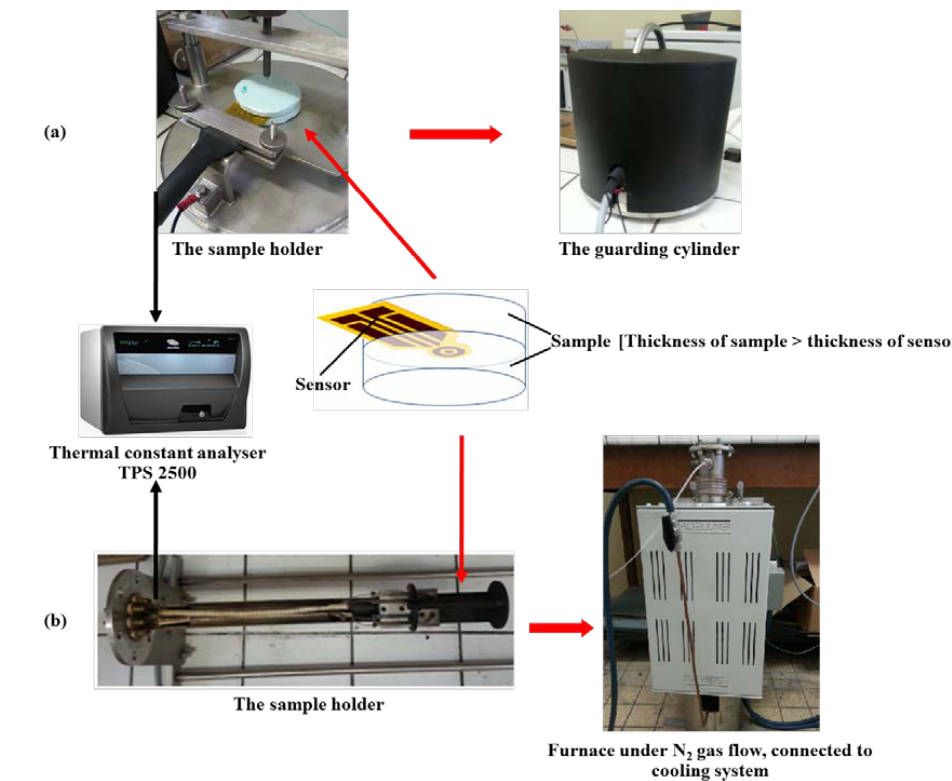
Figure 3. Experimental setup for thermal conductivity measurement at ( a ) room temperature and ( b ) elevated